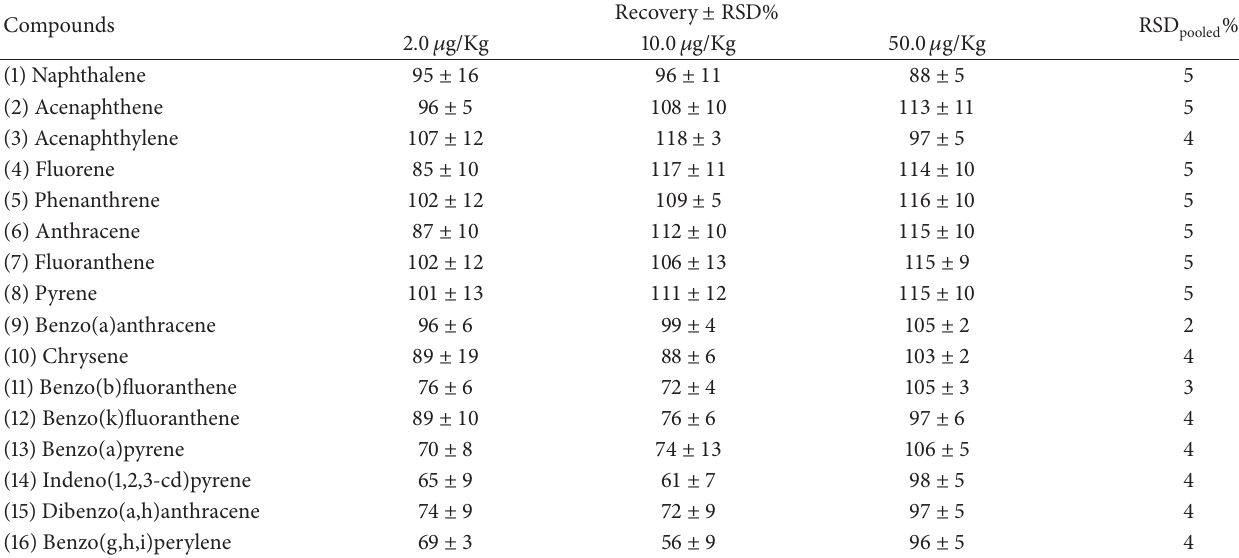
% results of 𝑛 = 6 replicates on each spiking